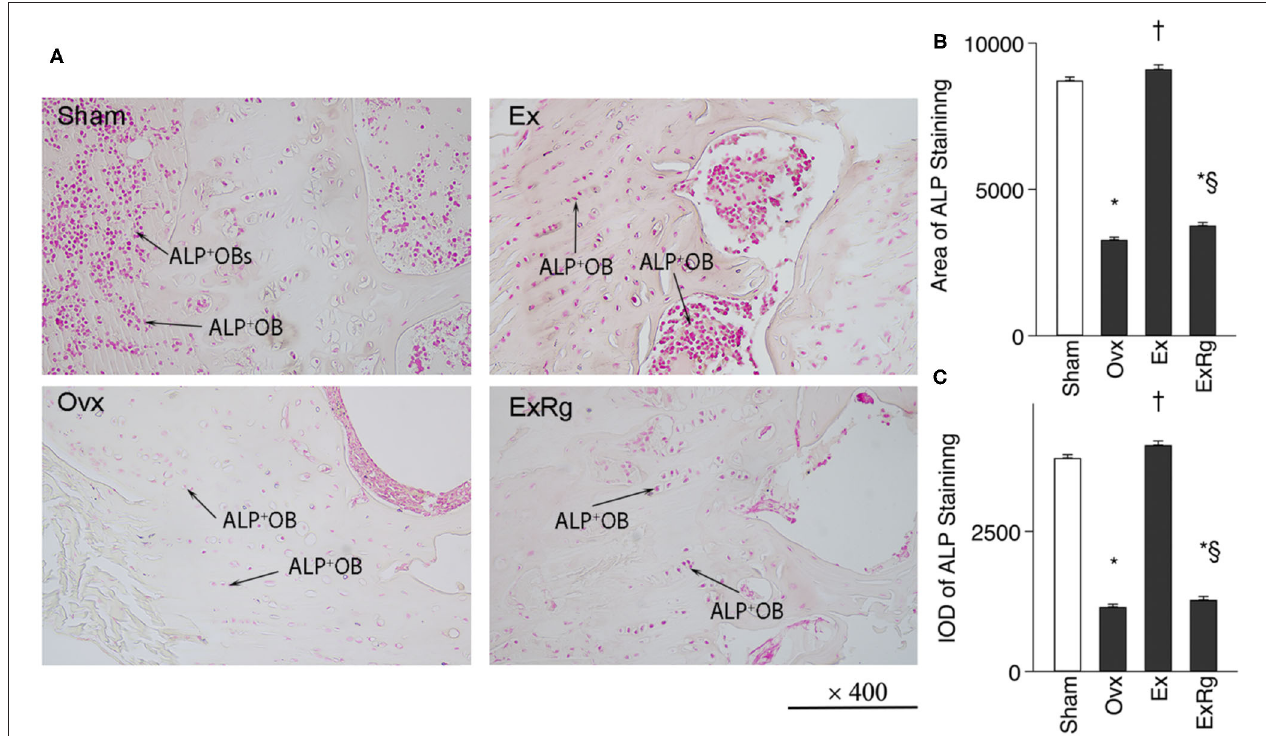
FIGURE 2 | ALP staining and quantitative analysis. (A) ALP (alkaline phosphatase) staining was performed for sham, ovariectomized (Ovx), Ovx plus exercise (Ex), and Ovx plus exercise and cRGDyk (ExRg) groups (each group, n = 10). (B) ALP staining area. (C) ALP staining IOD (integral optical density). ALP + OB, ALP positive osteoblast. *The difference between Sham group and Ovx, Ex, and ExRg groups was significant ( p < 0.05). † The difference between Ovx group and Ex and ExRg groups was significant ( p < 0.05). § The difference between Ex group and ExRg group was significant ( p <